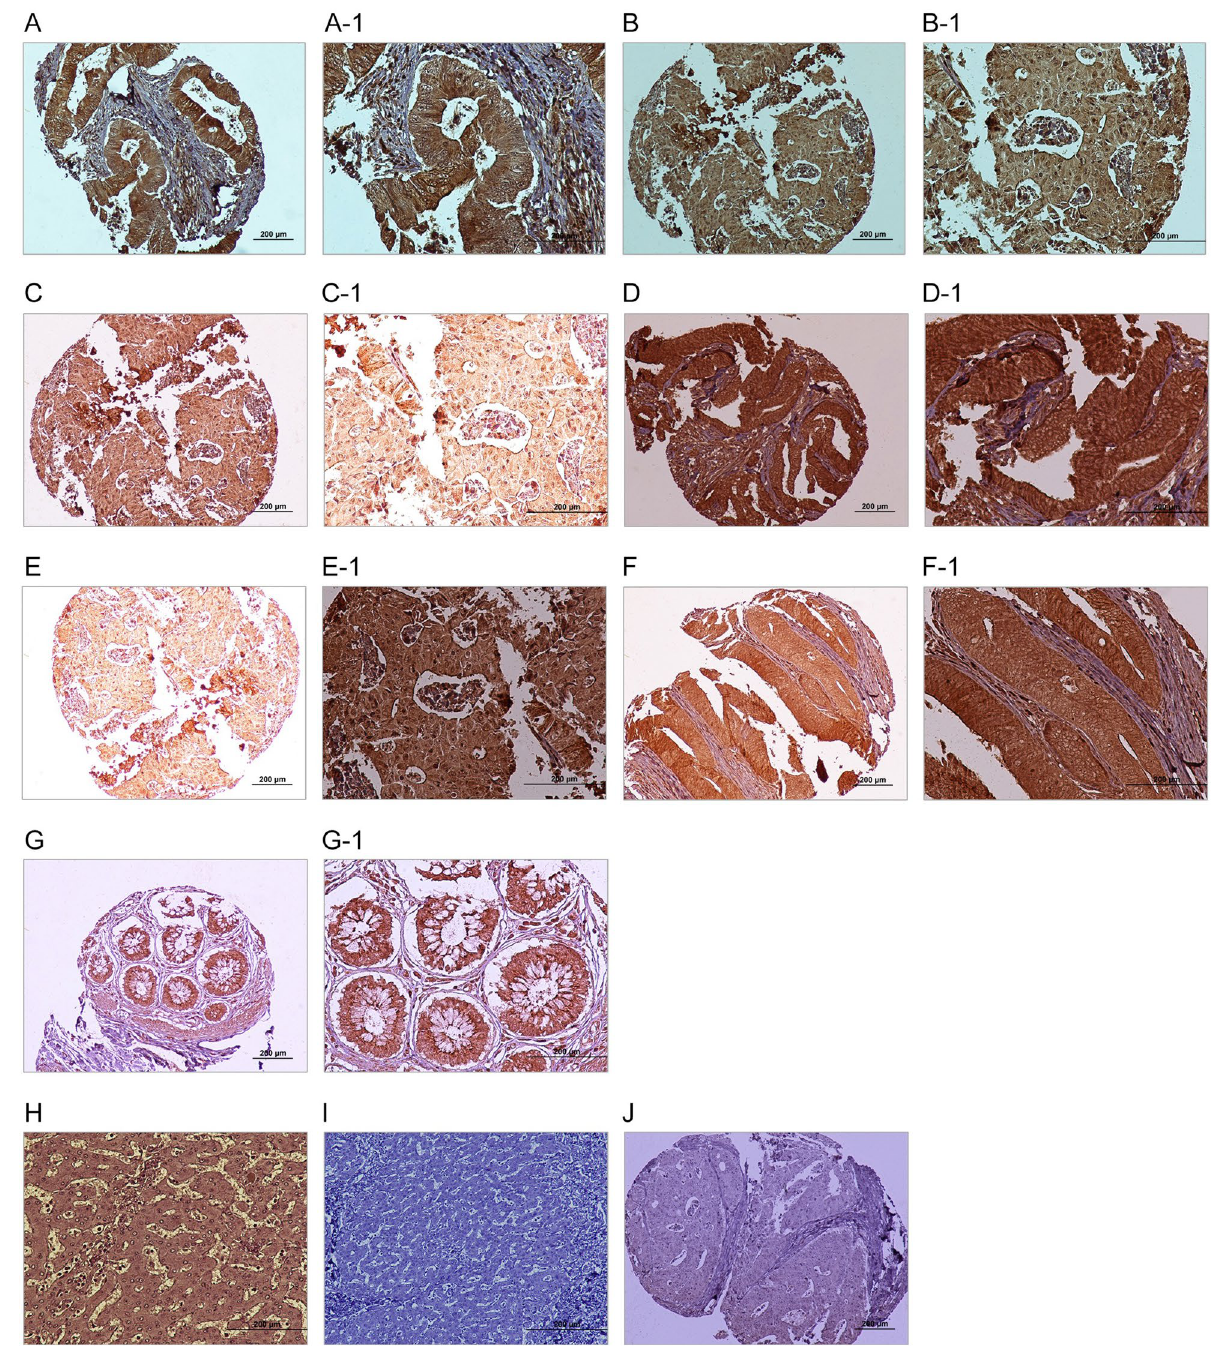
Figure 5. Immunohistochemical analysis of DDIT4 expression in colorectal cancer (CRC) samples. Nuclear expression of DDIT4 in CRC: ( A , A-1 ) low expression and ( B , B-1 ) high expression. Cytoplasmic expression of DDIT4 in CRC: ( C , C-1 ) low expression and ( D , D-1 ) high expression. Membranous expression of DDIT4 in CRC: ( E , E1 ) low expression and ( F , F1 ) high expression. ( G , G1 ) DDIT4 expression in adjacent normal tissue. ( H ) DDIT4 expression in normal human liver as a positive control, ( I ) DDIT4 expression in normal human liver as a negative control, and ( J ) Isotype control. (Figures shown with magnification of 100 × and 200